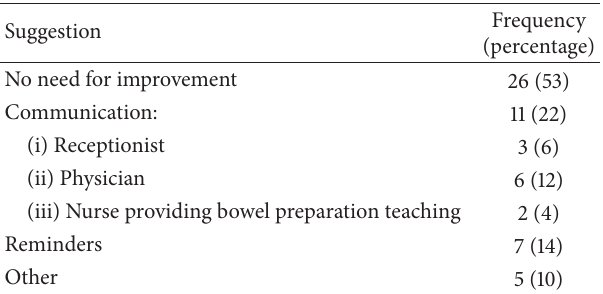
Table 3: Patient suggestions for improving colonoscopy